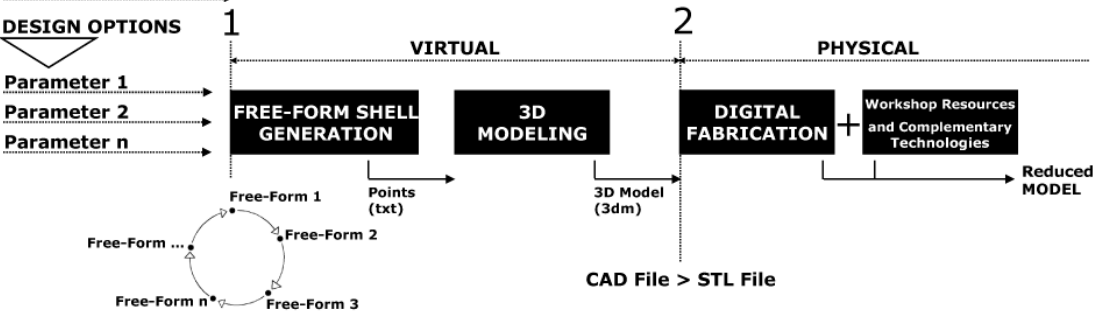
Figure 3. Flow chart of the process with transition key-moments: (1) from conceptual to virtual; (2) from virtual to physical reality.